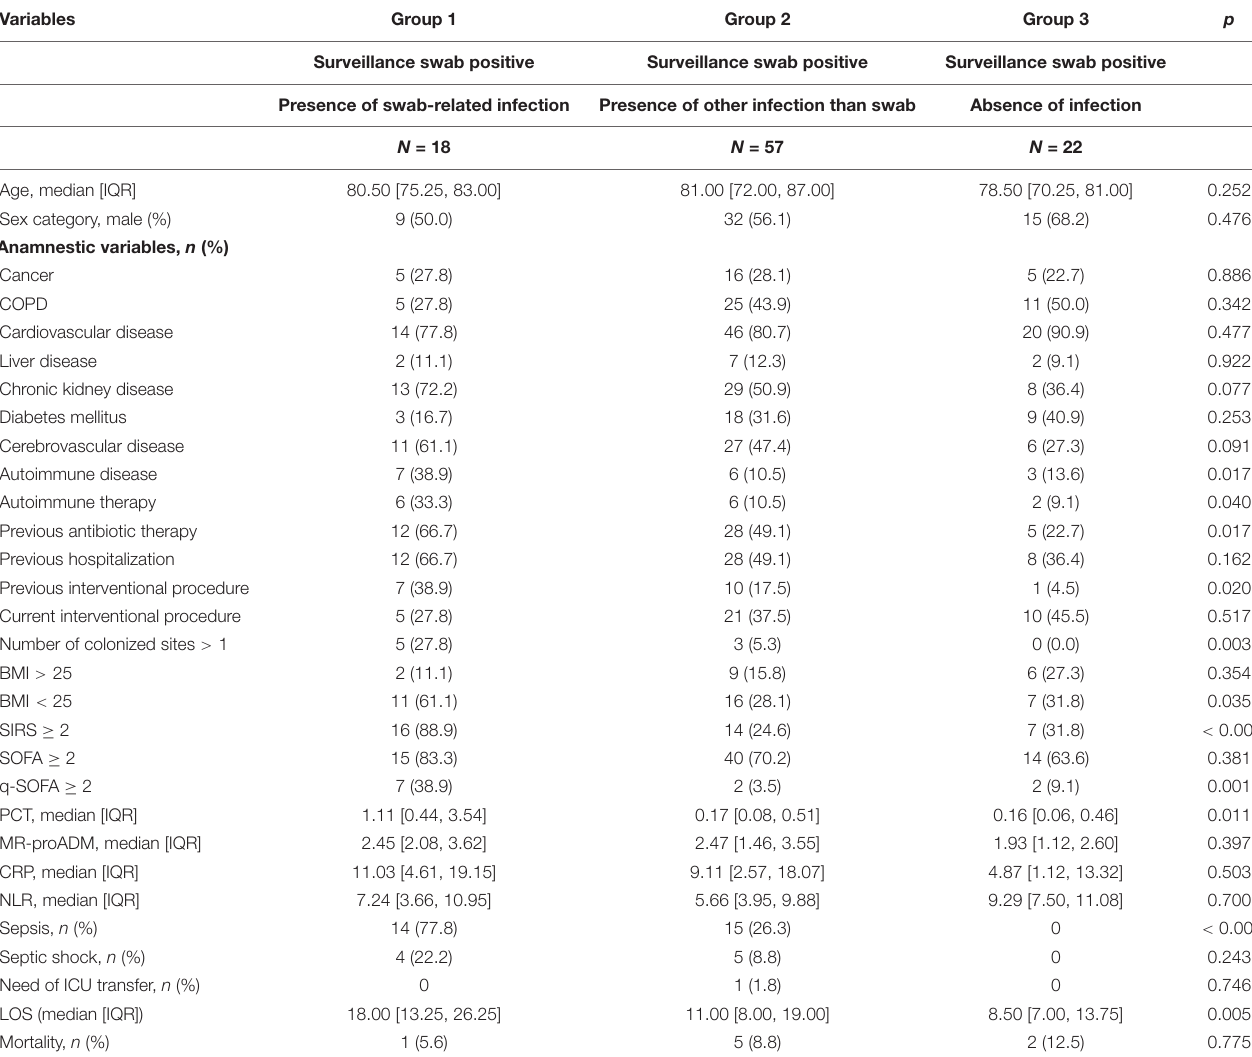
TABLE 1 | Demographic characteristics, clinical scores, and inflammatory biomarkers of the study population classified into three different groups: Group 1, Group 2, and Group 3.